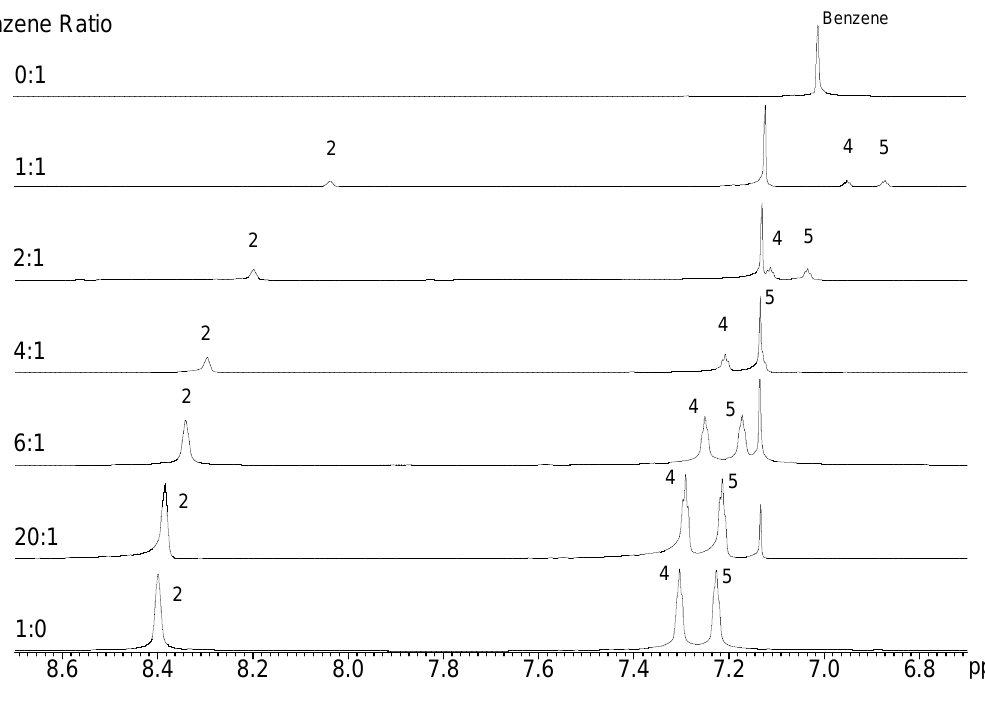
Figure 2. 1 H NMR spectra of different compositions of BMI.N(Tf) and benzene at 25 ºC evidencing 2 the signals shifts due to the interaction between the hydrogens of the IL ring and those of the aromatic ring of